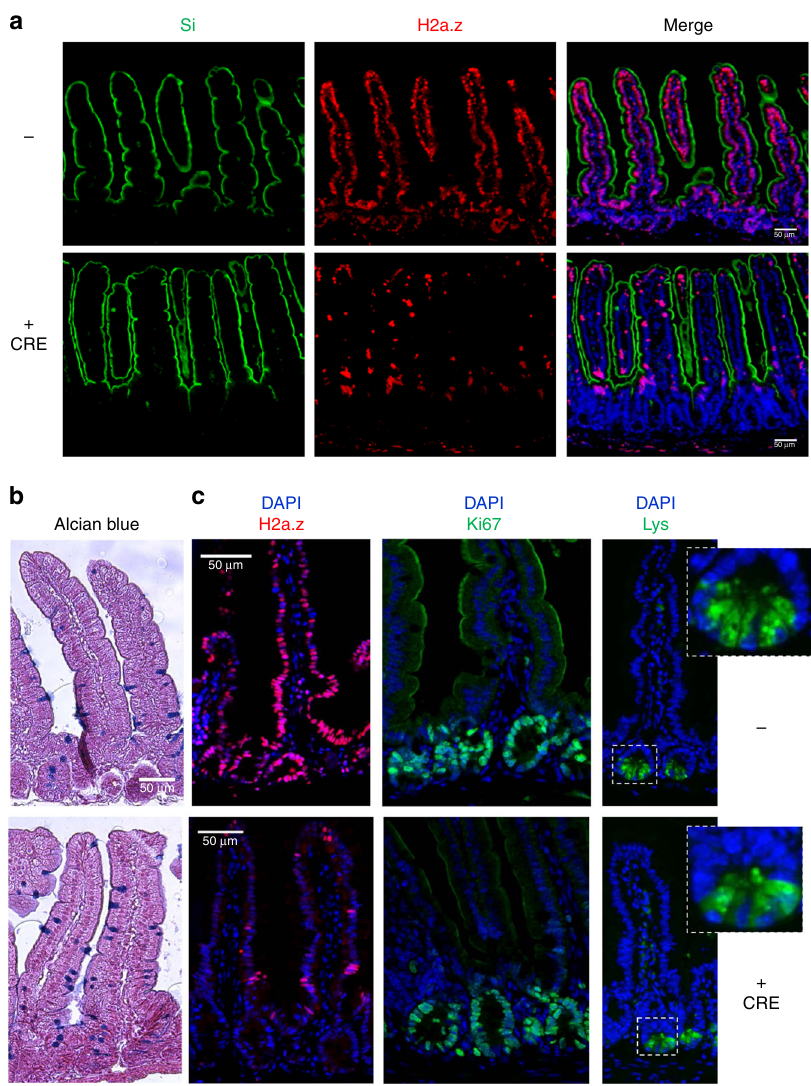
Fig. 3 Regulation of markers accumulation in tissues upon H2a.z depletion. a Immuno fl uorescence experiments on sections of small intestine from mice expressing ( + CRE) or not ( − ) the CRE recombinase and treated for 10 days with a tamoxifen-containing feed before dissection. The indicated speci fi c antibodies were used, as well as DAPI to stain nuclei (in blue in merge panels), for staining tissues from representative individuals. b Alcian blue staining, counterstained with nuclear fast red, was performed on sections, obtained as in a , to reveal mucin-producing cells. c Same as in a using the indicated antibodies and DAPI staining. All panels are representative of the same animals than in